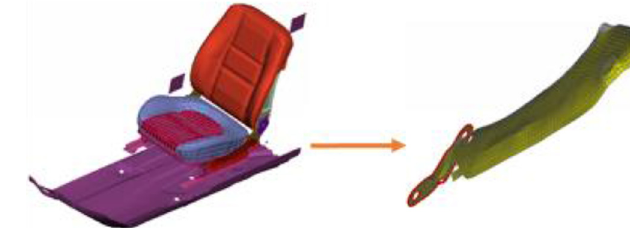
Fig. 9. Script output with R-Tree approach for to facilitate model connections.